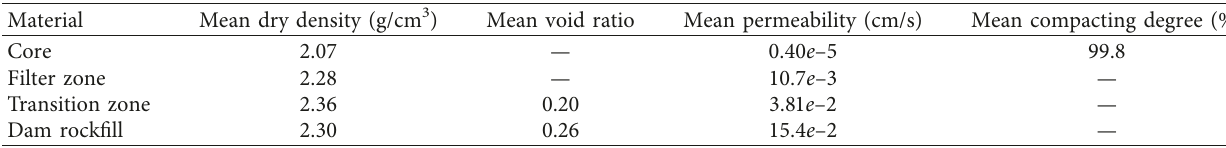
Table 4: Physical properties of the materials in the Qiaoqi dam.